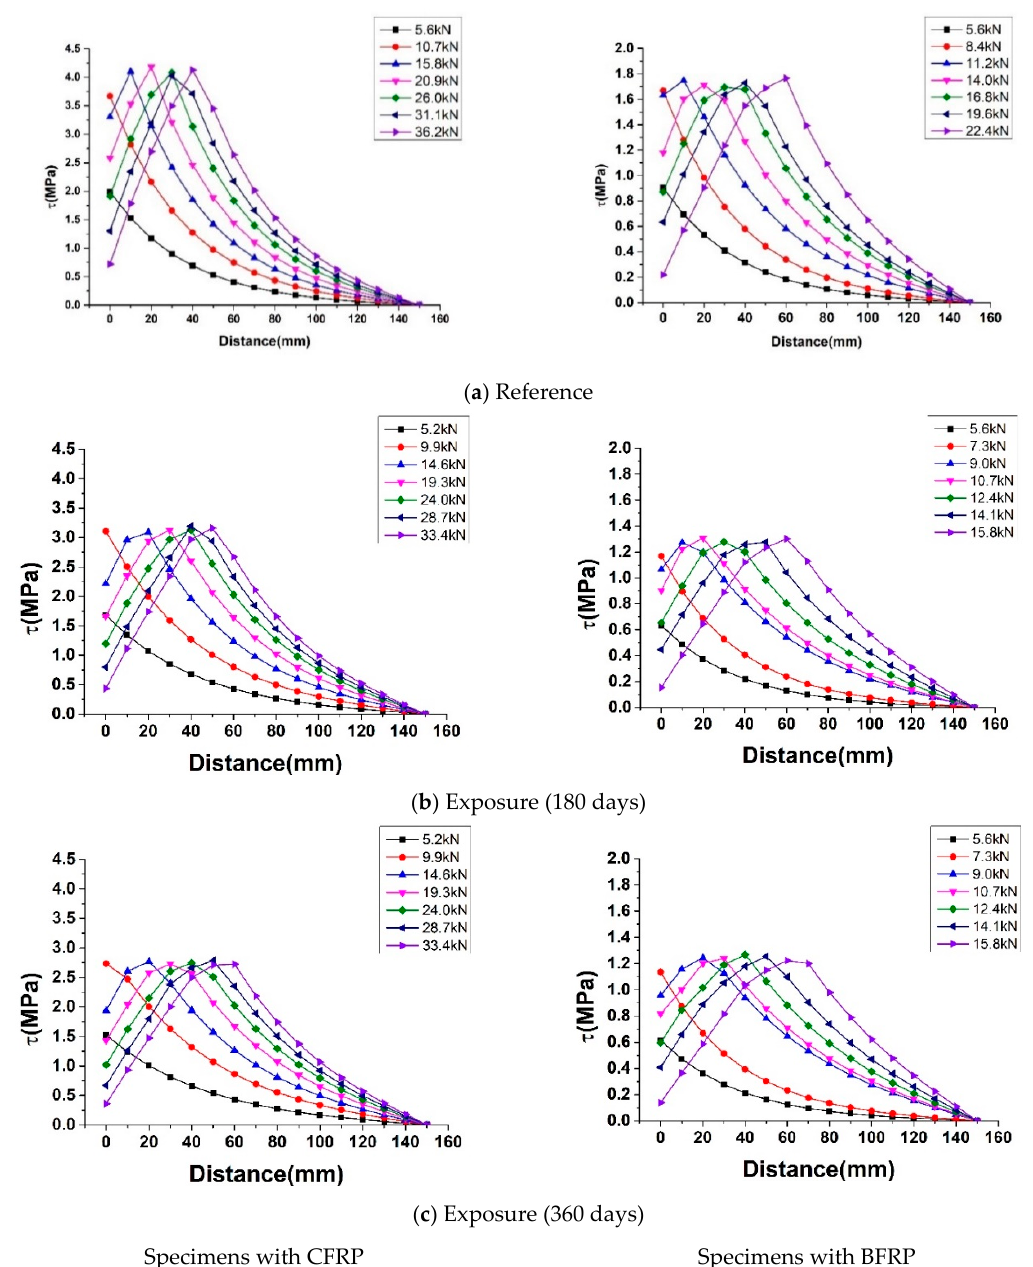
Figure 16. Theoretical results of interfacial shear stress distribution of specimens during the loading.